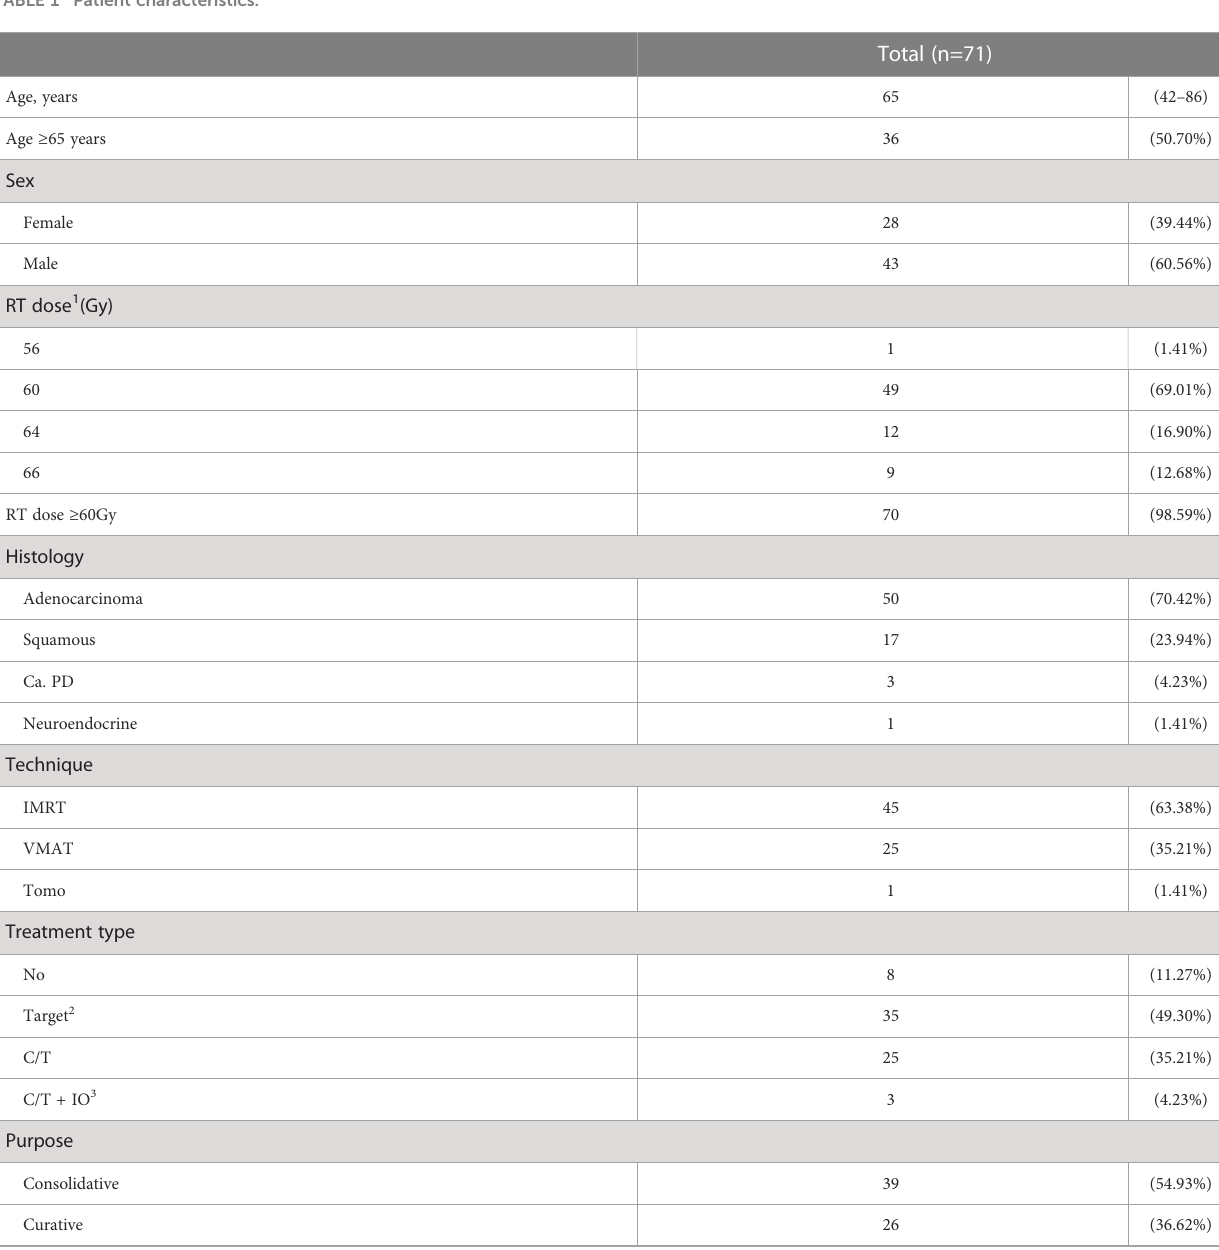
TABLE 1 Patient